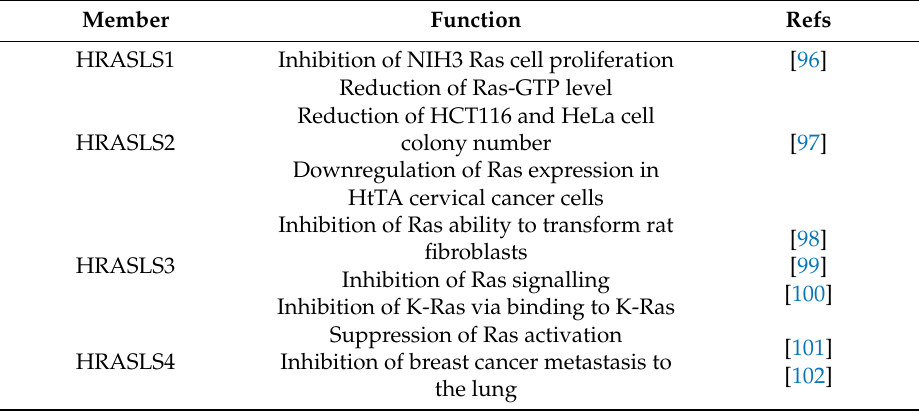
Table 2. HRASLS (H-Ras-like suppressor) family suppresses Ras